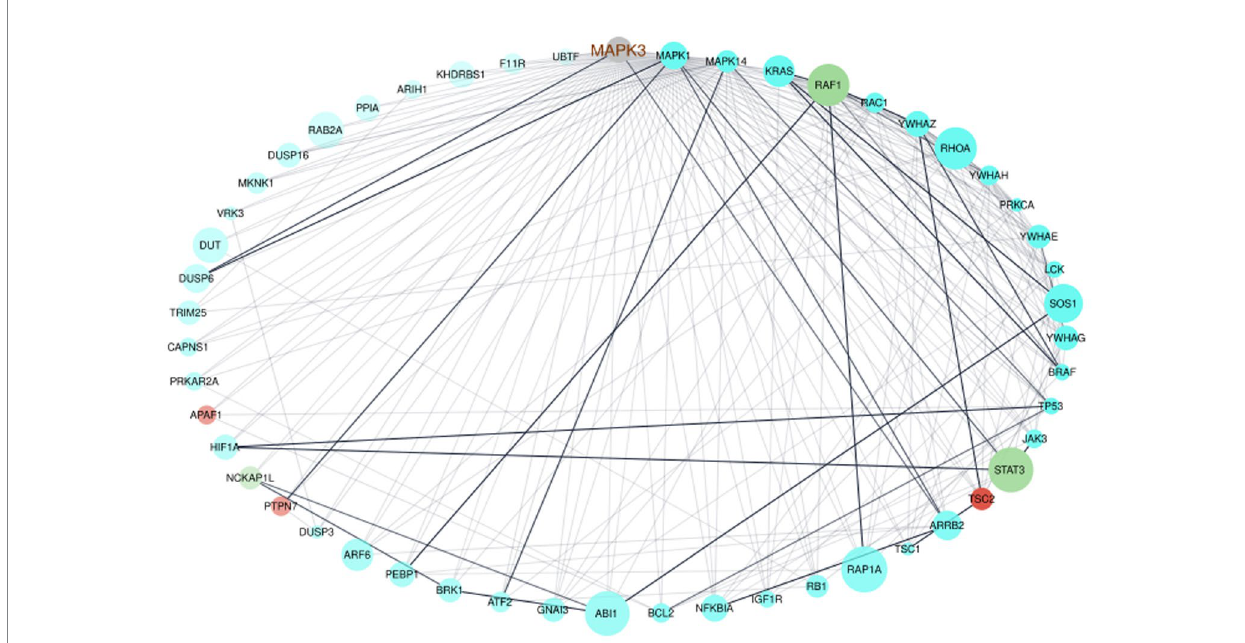
FIGURE 3 Network visualization of the interactome of MAPK3 and the genes from the turquoise, red, and greenyellow module. The nodes were colored by module, node size displays module membership score from WGCNA , the node sort and node transparency were set by STRING degree and the edge transparency was set by STRING score.